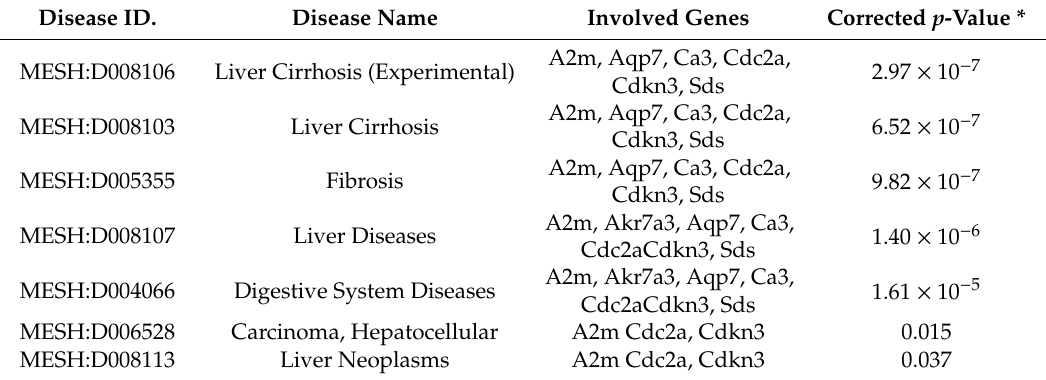
Table 5. Enriched Gene Ontology (GO) and disease terms of the time-invariant biomarkers. Disease ID. Disease Name Involved Genes Corrected p -Value